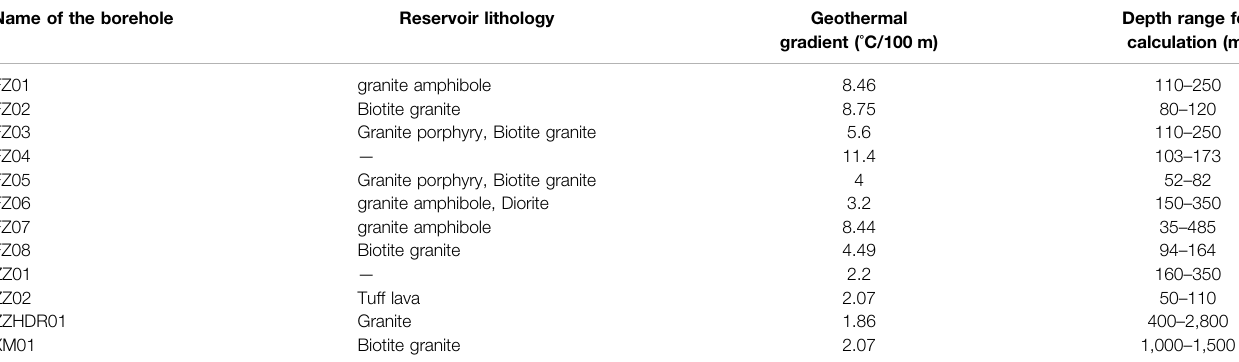
TABLE 2 | Reservoir lithology and geothermal gradient of representative borehole temperature measurement curves (Fujian Institute of Geological Survey, 2015). Name of the